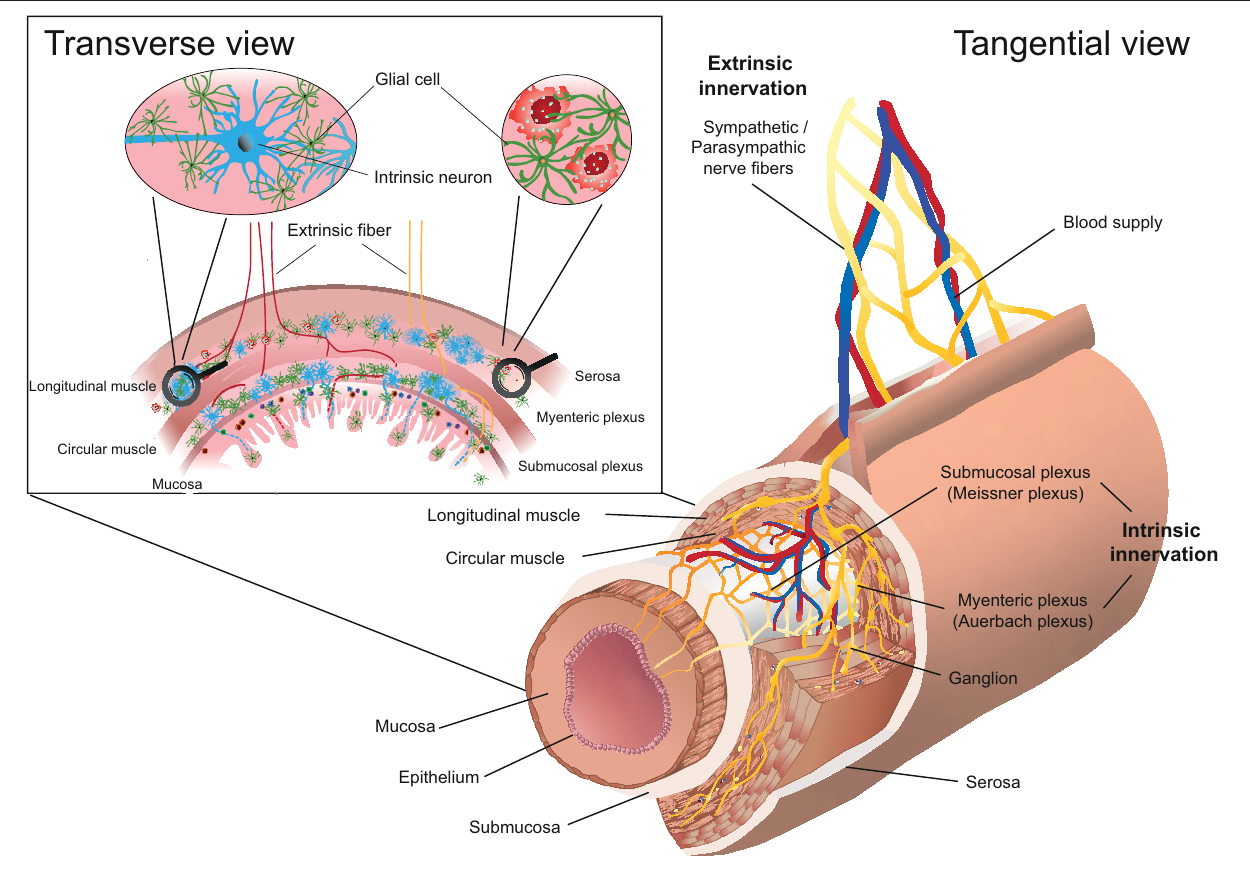
FIGURE 2 | Schematic representation of the enteric nervous system (ENS) in the intestine. The myenteric plexus (Auerbach plexus) lies within the longitudinal and the circular muscle layer, whereas the submucosal plexus (Meissner plexus) is located below the circular muscle layer. The transverse view of the intestinal wall shows the cellular composition of the ENS including neurons and glial cells. The innervation of the ENS is classified as intrinsic, if the neuron’s cell body lies within the intestinal wall and extrinsic, if the cell body of the neuron is located outside the intestinal wall.